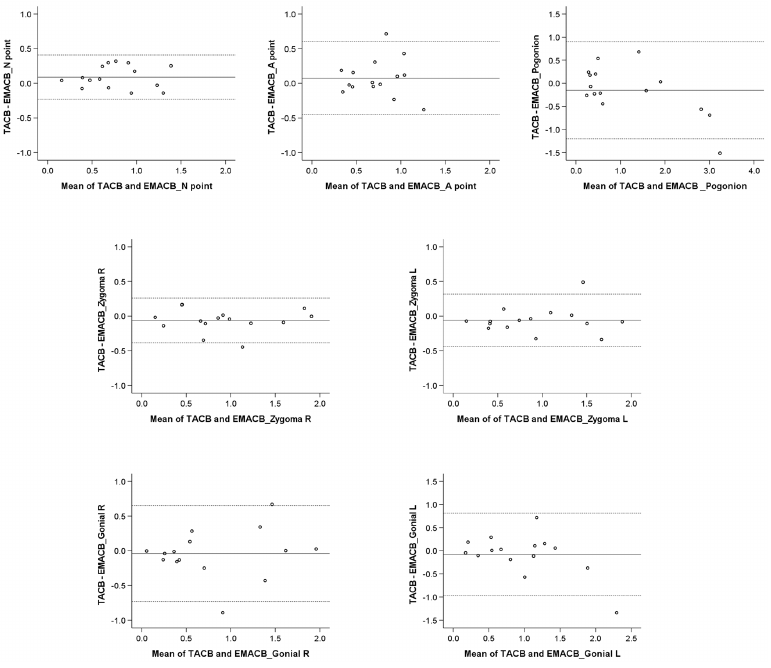
Figure 6. Bland–Altman plots on the T0–T1 changes (mm) detected through the TACB and the EMACB superimpositions by the same operator. The continuous horizontal line shows the mean of the differences in the detected T0–T1 changes, and the dashed lines show the corresponding 95% Limits of Agreement. TACB: Total Anterior Cranial Base; EMACB: Extended Middle Anterior Cranial Base.